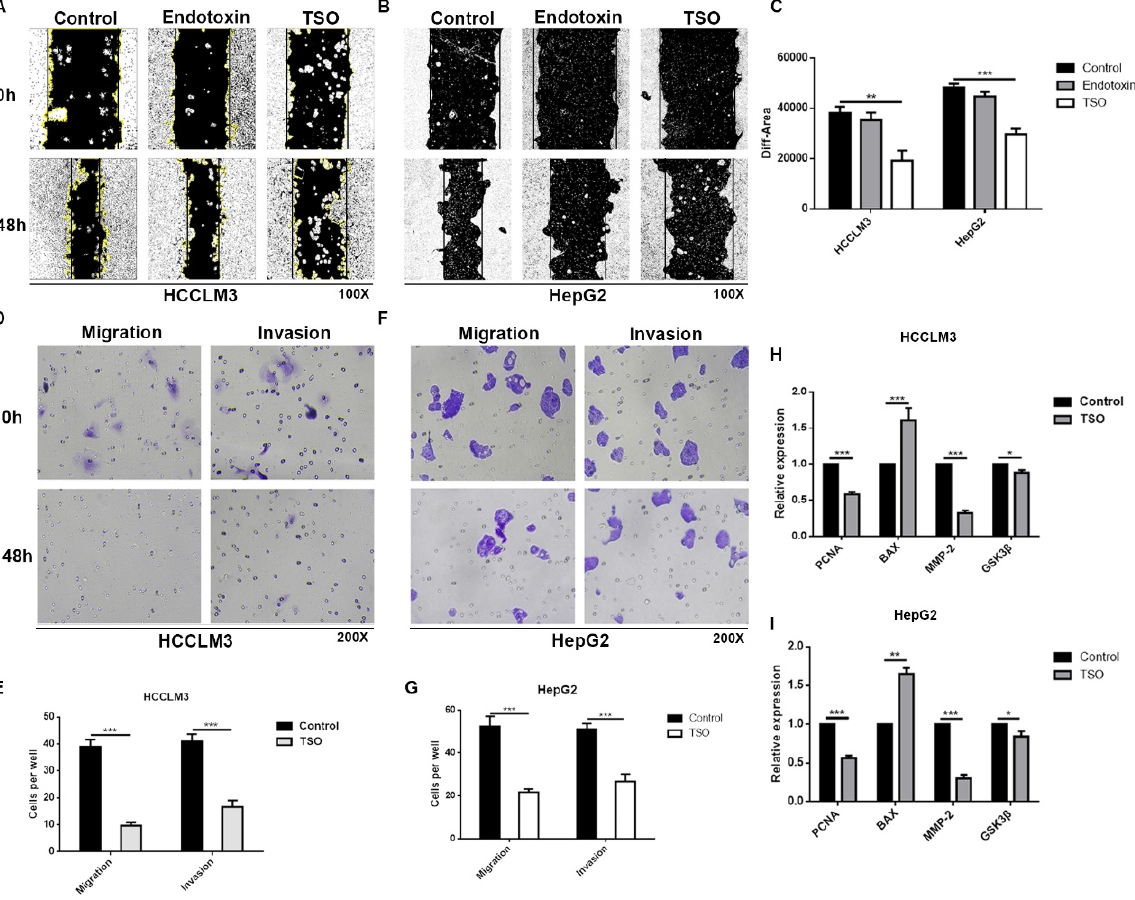
Figure 5. TSO can significantly inhibit the proliferation, migration, and invasion of HCCLM3 and HepG2 cells and promote apoptosis. ( A – C ) Wound healing assays showing the inhibition of TSO on the migratory abilities of HCCLM3 cells and HepG2 cells. ( D – G ) Transwell assays in HCCLM3 and HepG2 cells with TSO or control. ( H , I ) The mRNA level of PCNA, BAX, MMP-2, and GSK-3 β in HCCLM3 cells and HepG2 cells after TSO treatment as determined by real-time PCR (SYBR Green). Data are mean ± SD, n = 3; * p < 0.05, ** p < 0.01 and *** p < 0.001 vs. Control.